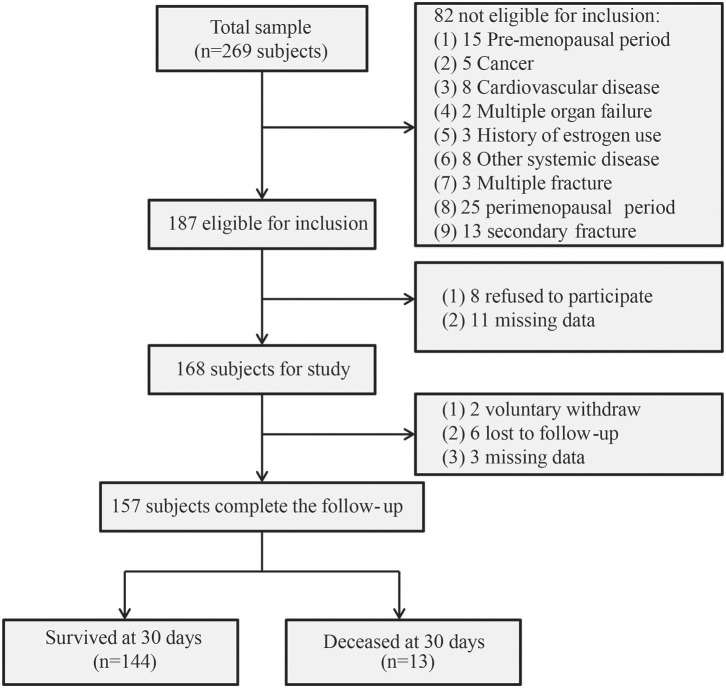
The study cohort flow diagram.